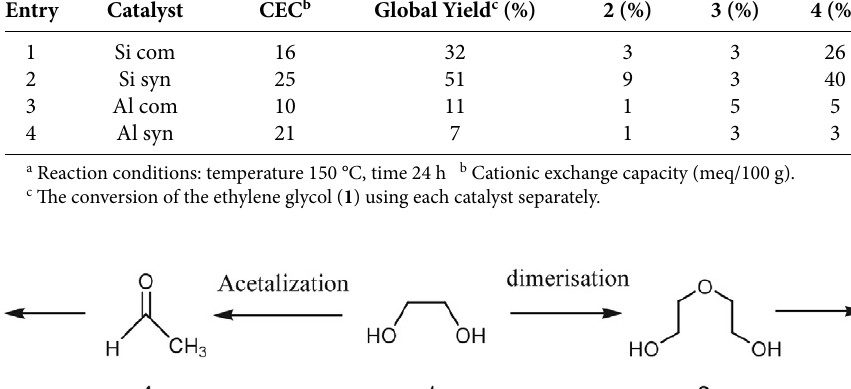
Table 2. Transformation of ethylene glycol ( 1 ) by silica gel and alumina catalysts a Entry Catalyst